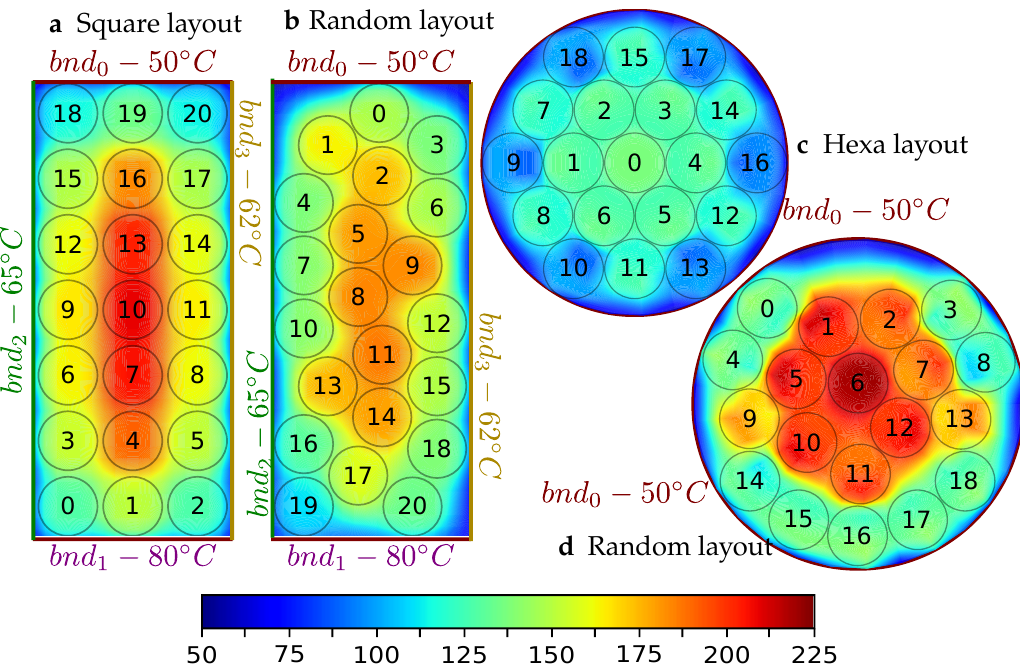
Figure 10. Temperatures contour for 2 shapes and 2 layouts. Results data from Tables 1 and